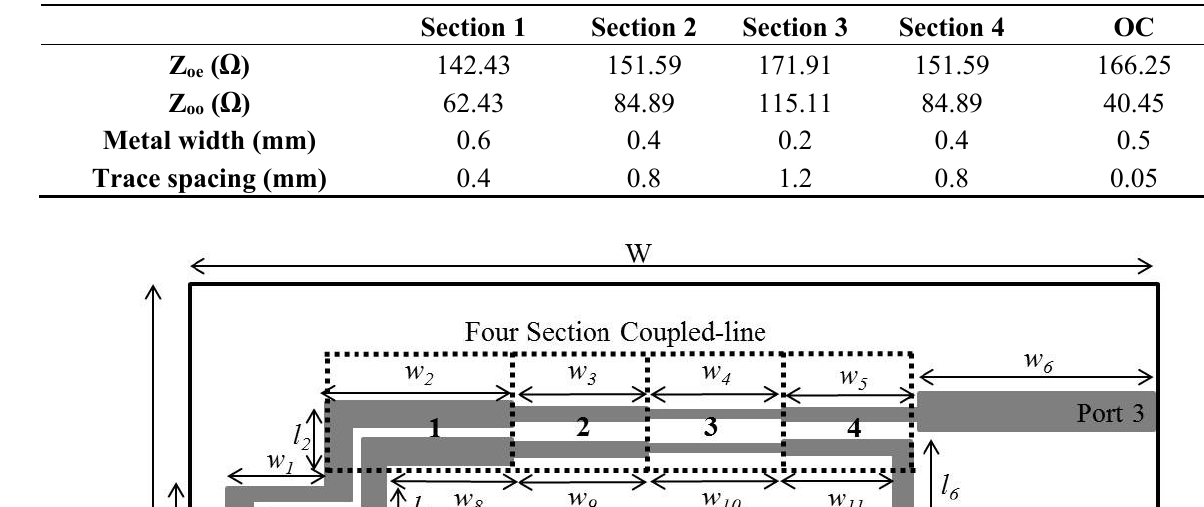
Table 1. Even- and odd-mode impedances of each section.